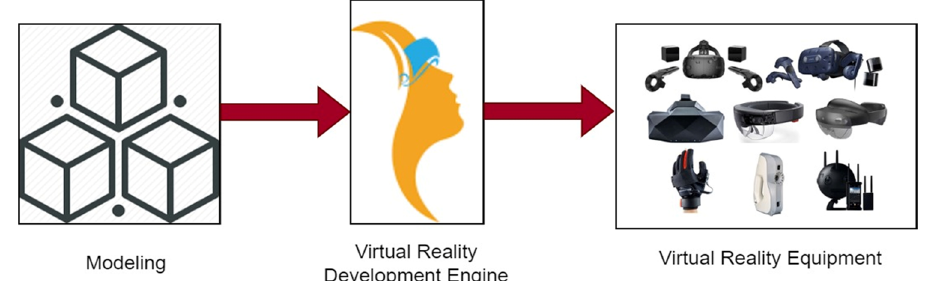
Figure 3: Development